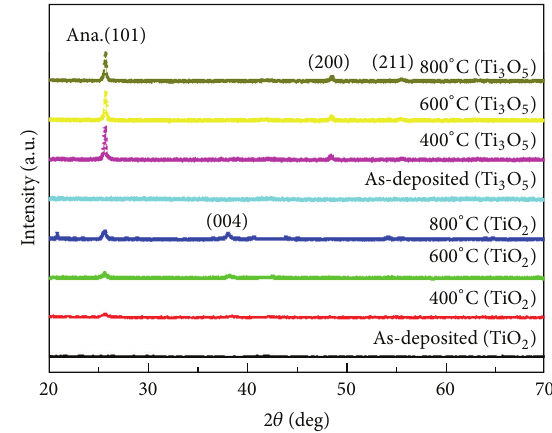
Figure 9: X-ray diffraction patterns of TiO 2 films from Ti 3 O 5 and TiO 2 starting materials annealed at different